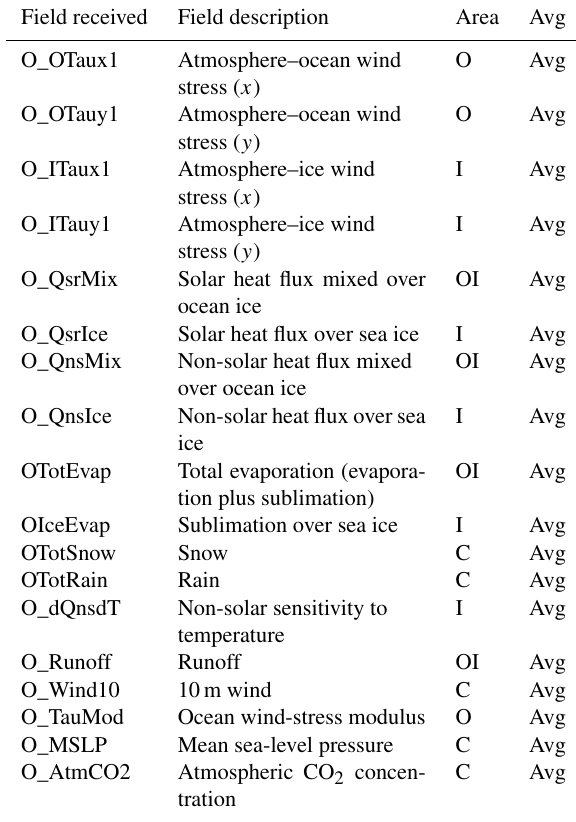
Table A3. Fields received by CanNEMO from CanCPL. Descrip- tions are as in Table